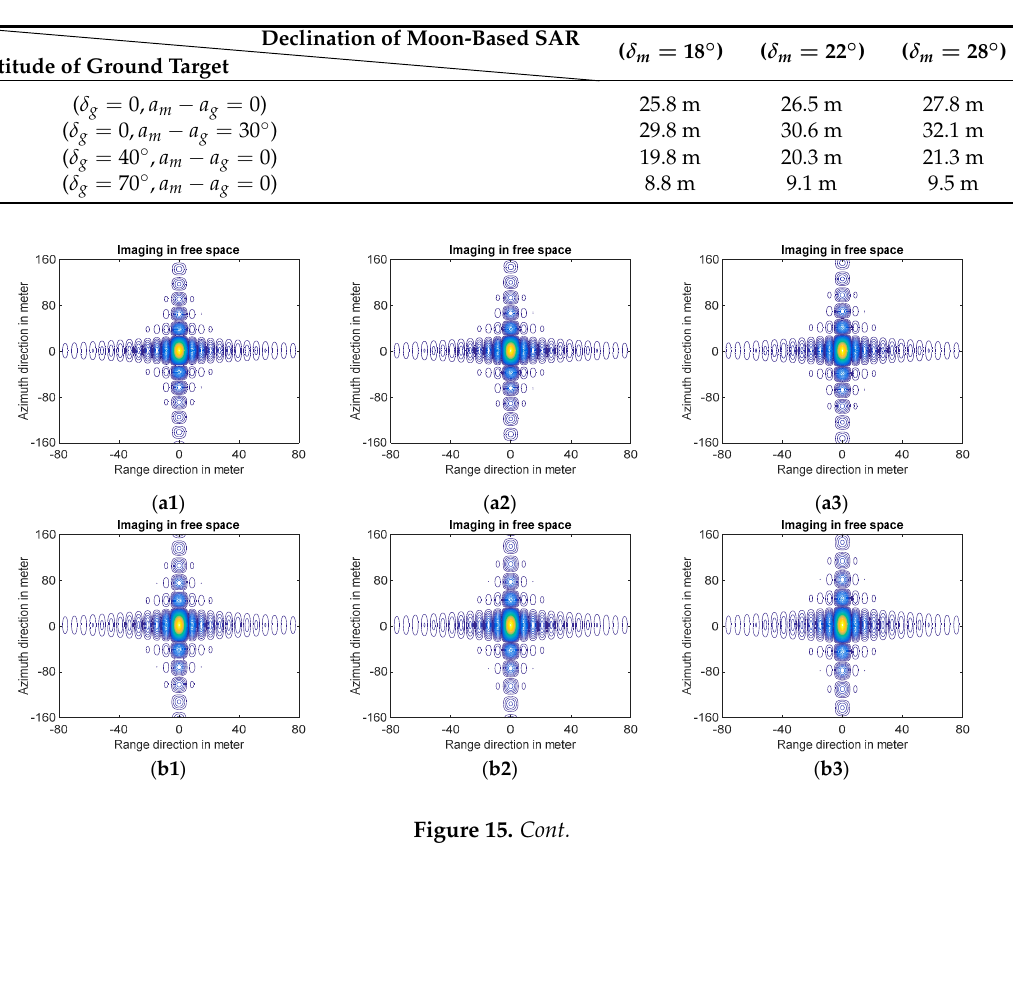
Table 3. Azimuthal Resolution of Simulation Results.